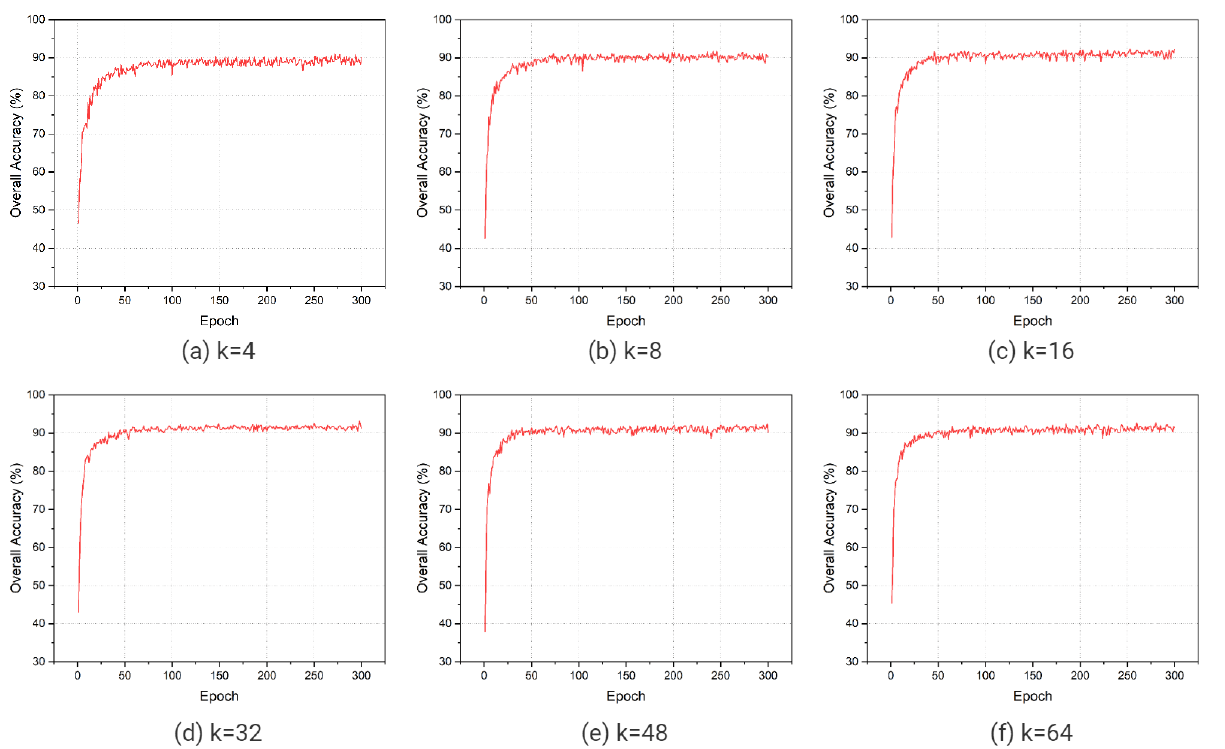
Figure 5. Six run results (OA) of TR-Net with different neighbors on ModelNet40 test dataset. We use k to denote the number of neighborhood point sets sampled for each point.